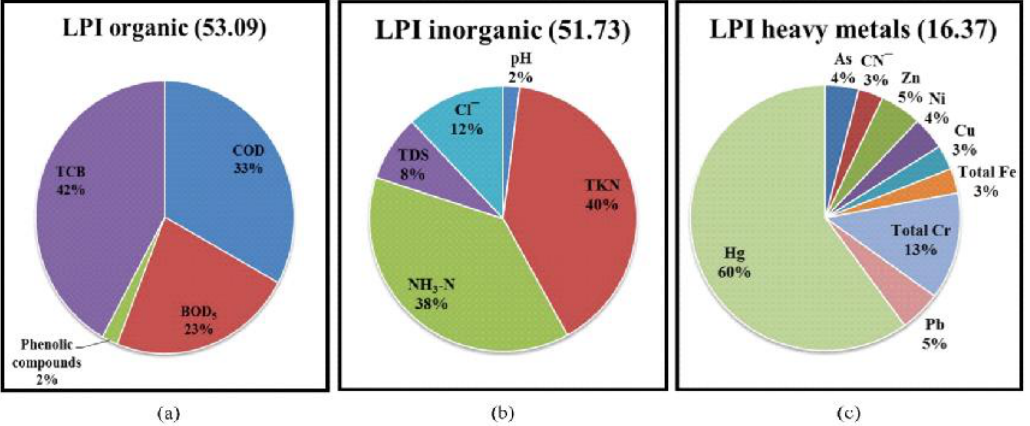
Fig. 2: Percentage distribution of the components of (a) LPI organic, (b) LPI inorganic and (c) LPI heavy metals for the active dumping ground at Dhapa, Kolkata